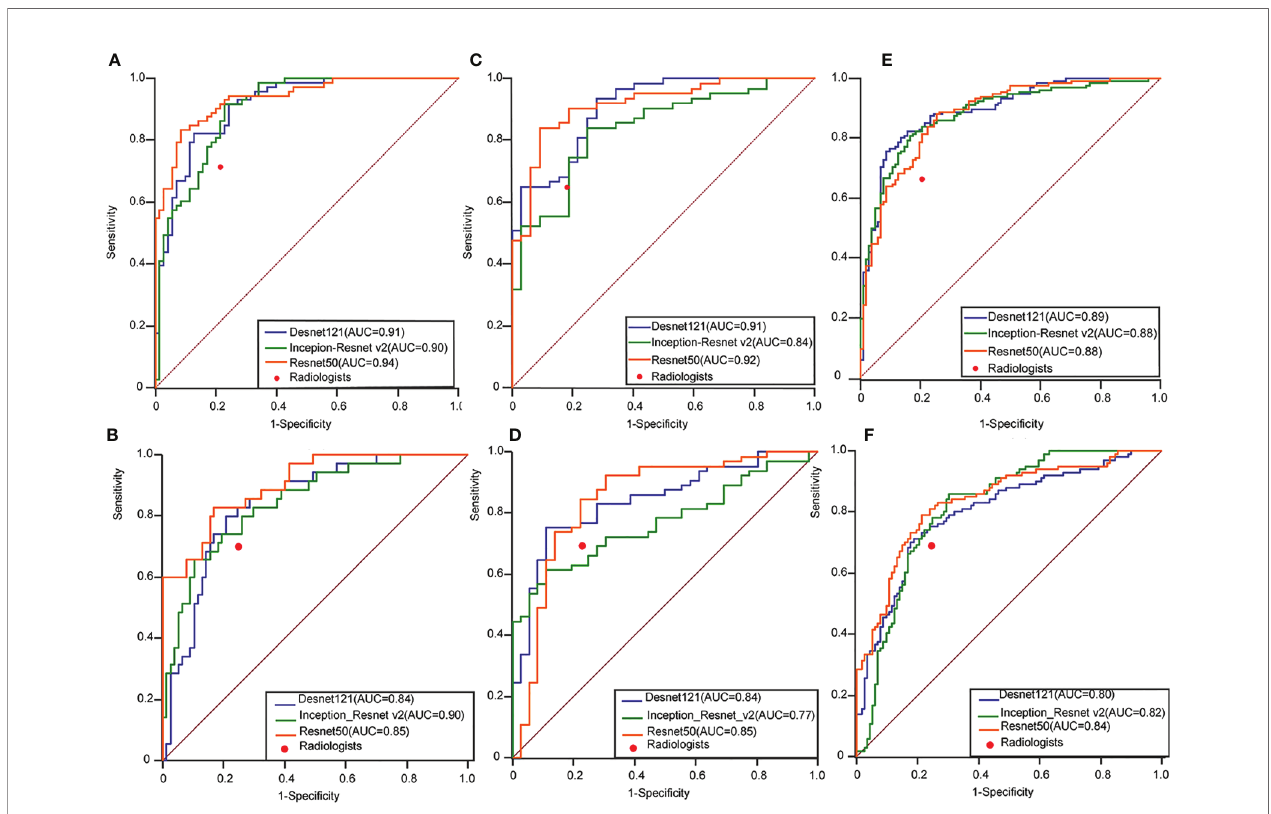
FIGURE 3 | Performance of the ensemble D-CNN models in identifying patients with thyroid cancer in TR4 (A) , TR5 (C) , and TR4&5 (E) on three inner test datasets and TR4 (B) , TR5 (D) , and TR4&5 (F) on three outer test datasets. The red dots on each ROC curve demonstrate the performance of the radiologists. AUC, area under the curve; DCNN, deep convolutional neural network; ROC, receiver operating characteristics